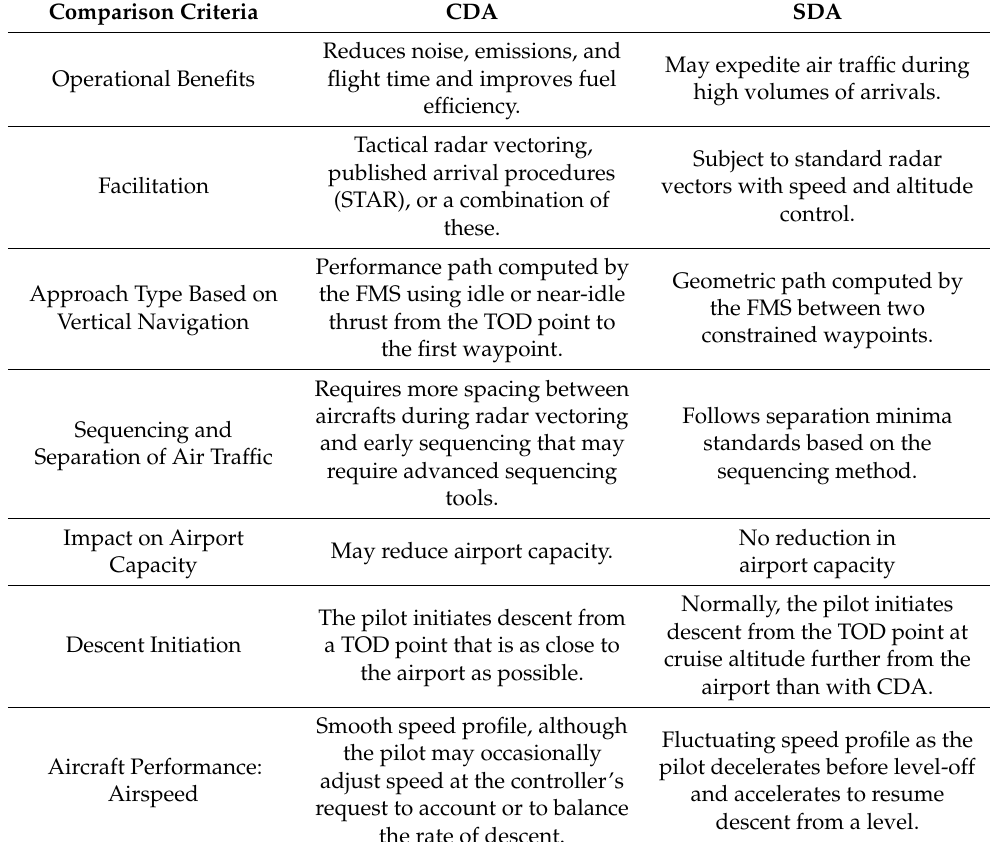
Table 1. Summary of the Differences between CDA and SDA. Comparison